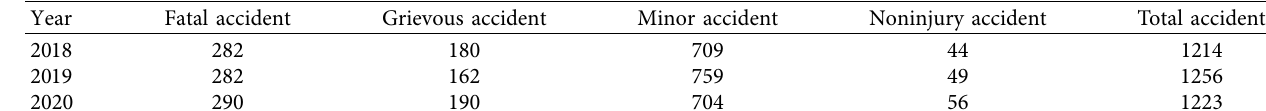
Table 2: Accident data for Tirunelveli city.